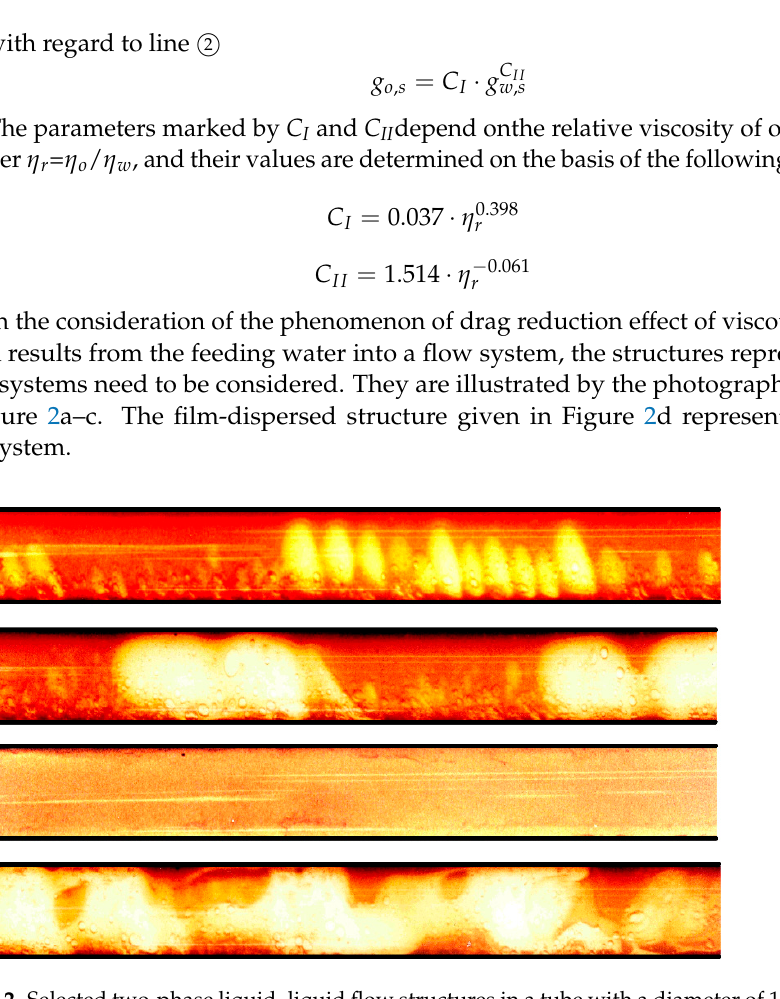
Figure 2. Selected two-phase liquid–liquid flow structures in a tube with a diameter of 12 mm (photos from the author’s archive) ( a ) water droplets in oil, ( b ) plugs and drops of water in oil, ( c ) water dispersion in oil,( d ) film-dispersed flow of phases.